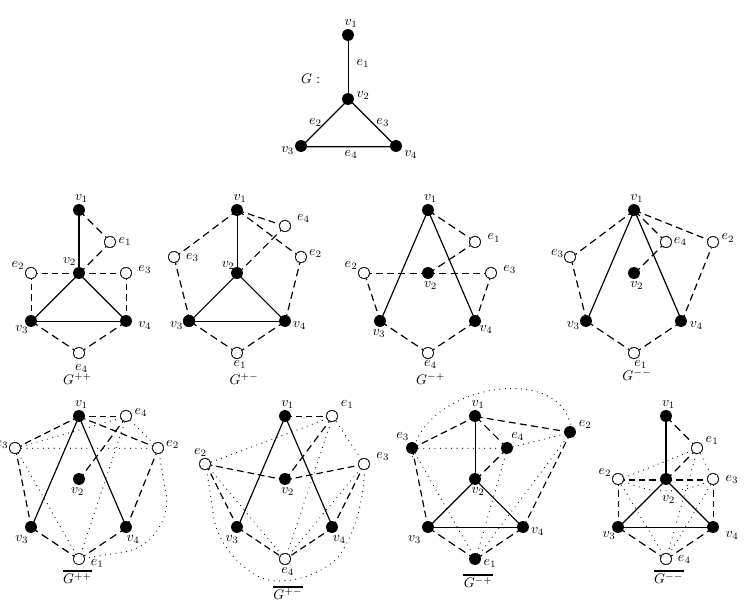
Figure 1: Graph G , its generalized transformation G xy and their complements G